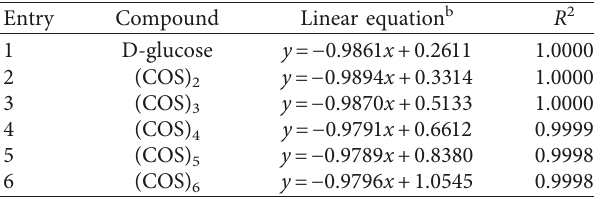
Table 2: Linearity of the log 10 RTversus log 10 flow rate (log 10 FR) of each single COS separated by HPAEC on a CarboPacPA-100 column.